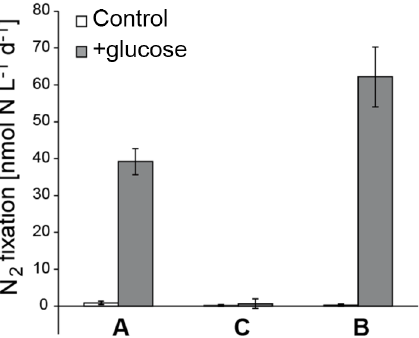
Figure 5. N 2 fixation in response to glucose fertilization experi- ment performed in eddies A1 (100m), B (125m) and C (100m); samples were derived from the eddy core waters; depths are given in brackets.